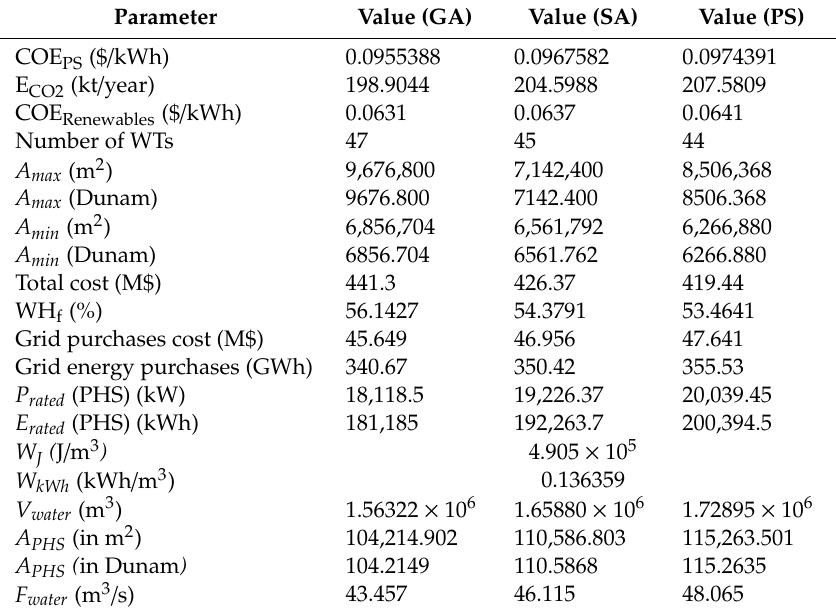
Table 4. Detailed results of the optimized system using genetic algorithm (GA), simulated annealing (SA), and pattern search (PS) algorithms.